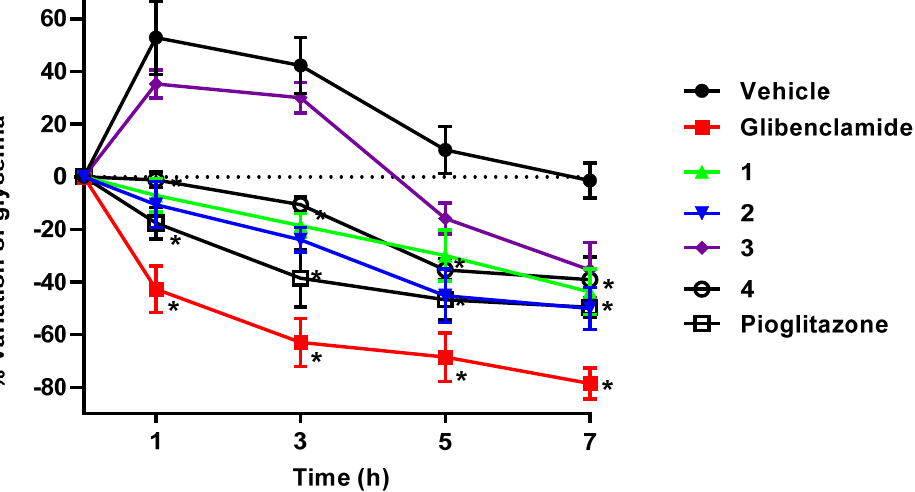
Figure 4. Effect of a intragastric single dose of 100 mg/kg of (thio)phenoxyisobutyric derivatives 1 – 4 , glibenclamide, and pioglitazone on blood glucose levels in STZ/NA-induced diabetic mice. * Statistically significant difference between control group and test samples were estimated using ANOVA and a multiple comparison Dunnett’s test ( n = 6, mean ± SEM, p < 0.05).